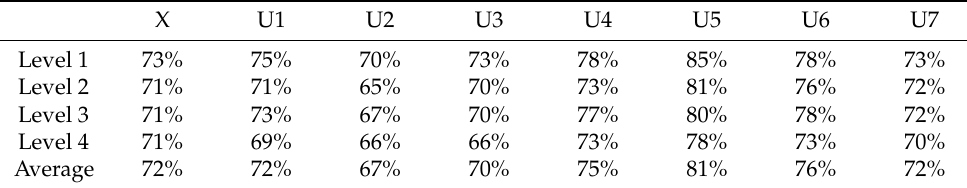
Table 6. Organizational units: compliance with the MSKMTI.